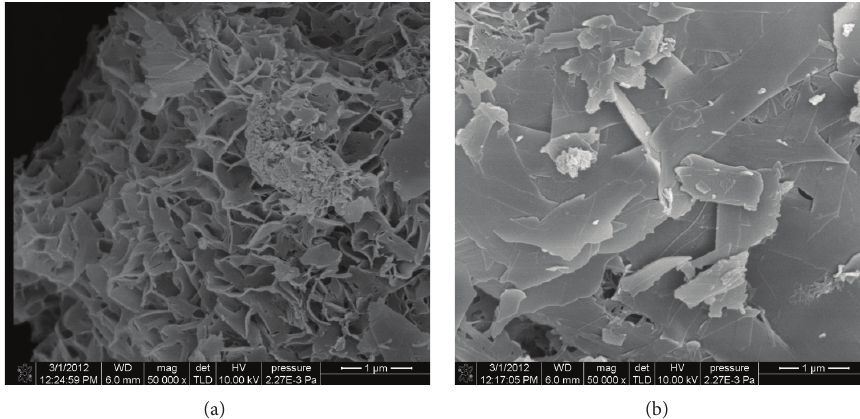
Figure 3: FESEM photographs of amorphous ceramics before and at the 6th time phosphate removal. (a) Amorphous ceramics before phosphate removal. (b) Amorphous ceramics of the 6th time phosphate removal.